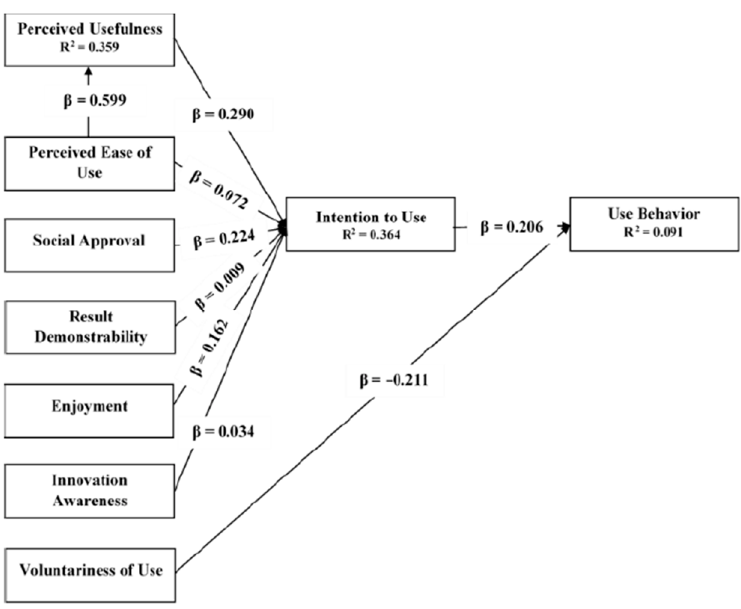
Figure 2. Validated research